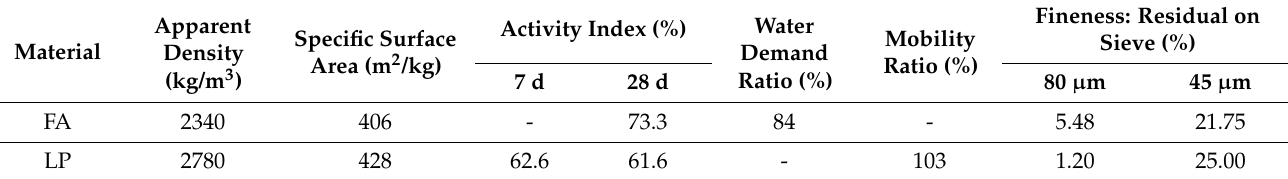
Table 4. Physical properties of fly ash and limestone Table 3. Physical and mechanical properties of cement .